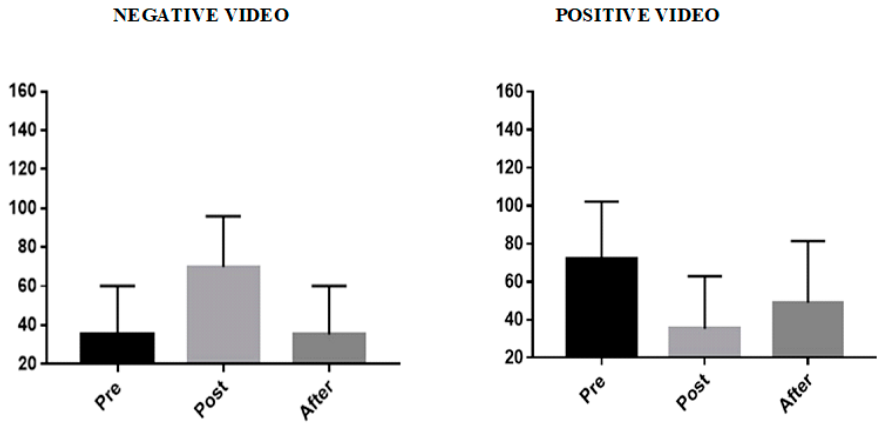
Figure A3. Results at the Negative and Positive